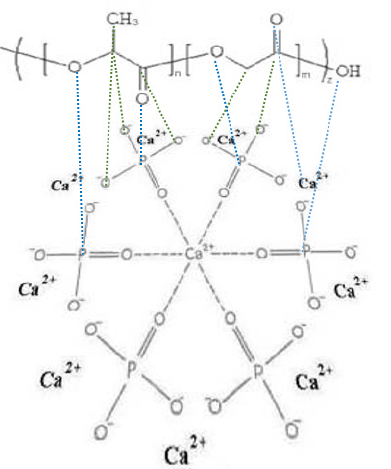
Figure 12. Scheme PLGA orientation of functional groups to the surface of HA.